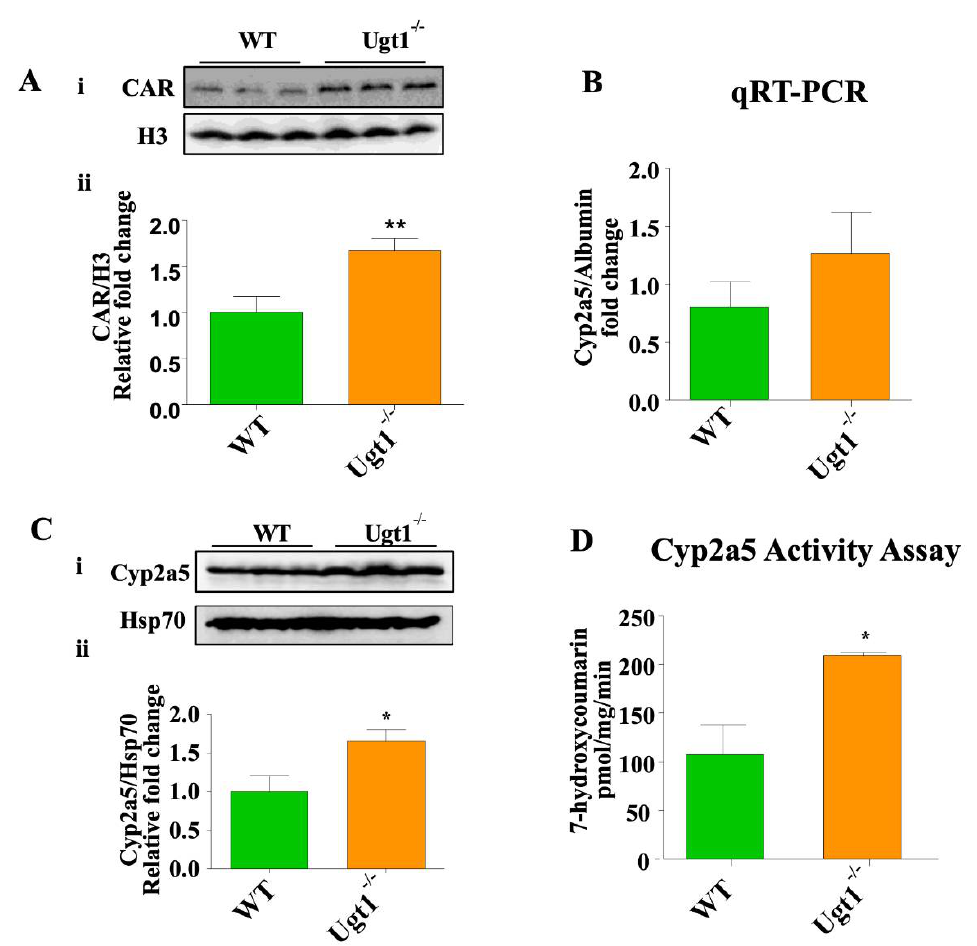
Figure 2. CAR and Cyp2a5 expression in the liver of WT and Ugt1 − / − animals. ( A ) i. Western blot analysis of nuclear CAR expression in the liver of WT and Ugt1 − / − adult mice. Histone H3 used as a nuclear loading control. ii. Quantification of the Western blot analysis. ( B ) qRT-PCR analysis of Cyp2a5. Albumin was used as the internal control. ( C ) i. Western blot analysis for Cyp2a5 expression from total liver protein extract of WT and Ugt1 − / − adult mice. Hsp70 was used as the loading control. ii. Quantification of Western blot analysis. ( D ) Liver Cyp2a5 activity assay in WT and Ugt1 − / − adult animals. Values represent mean ± SD. t -test was performed. * p < 0.05 and ** p < 0.01 were interpreted as statistically significant.